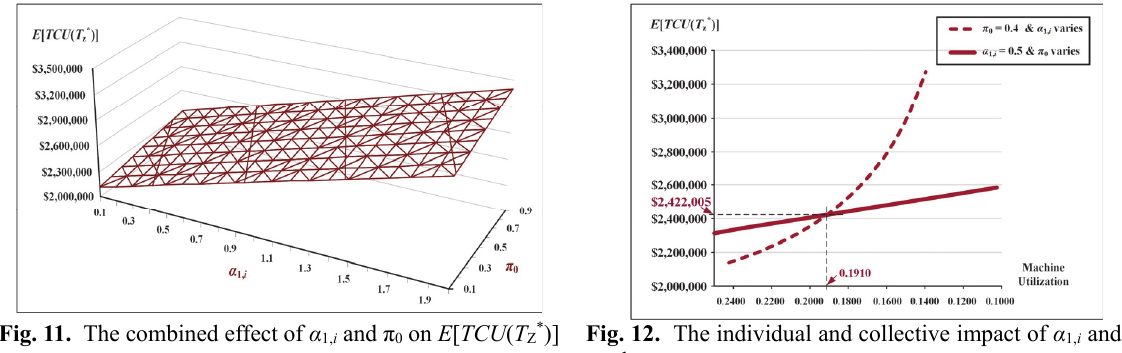
Fig. 11. The combined effect of α 1, i and π 0 on E [ TCU ( T Z* )] Fig. 12. The individual and collective impact of α 1, i and π 0 on the system cost